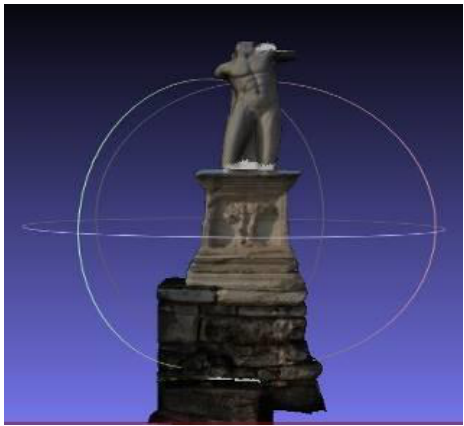
Figure 3: Giant statue of Odeion of Agrippa A time of flight (ToF) laser scanner, Scanstation 2 of Leica, was used in order to create the 3D models of the monuments without texture. For the texturing phase high resolution digital overlapping images were taken and then oriented and covered the scan models so as to create the final 3D texture models.